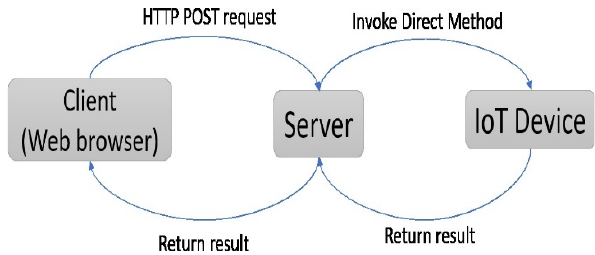
Figure 15. Communication between client and IoT device.